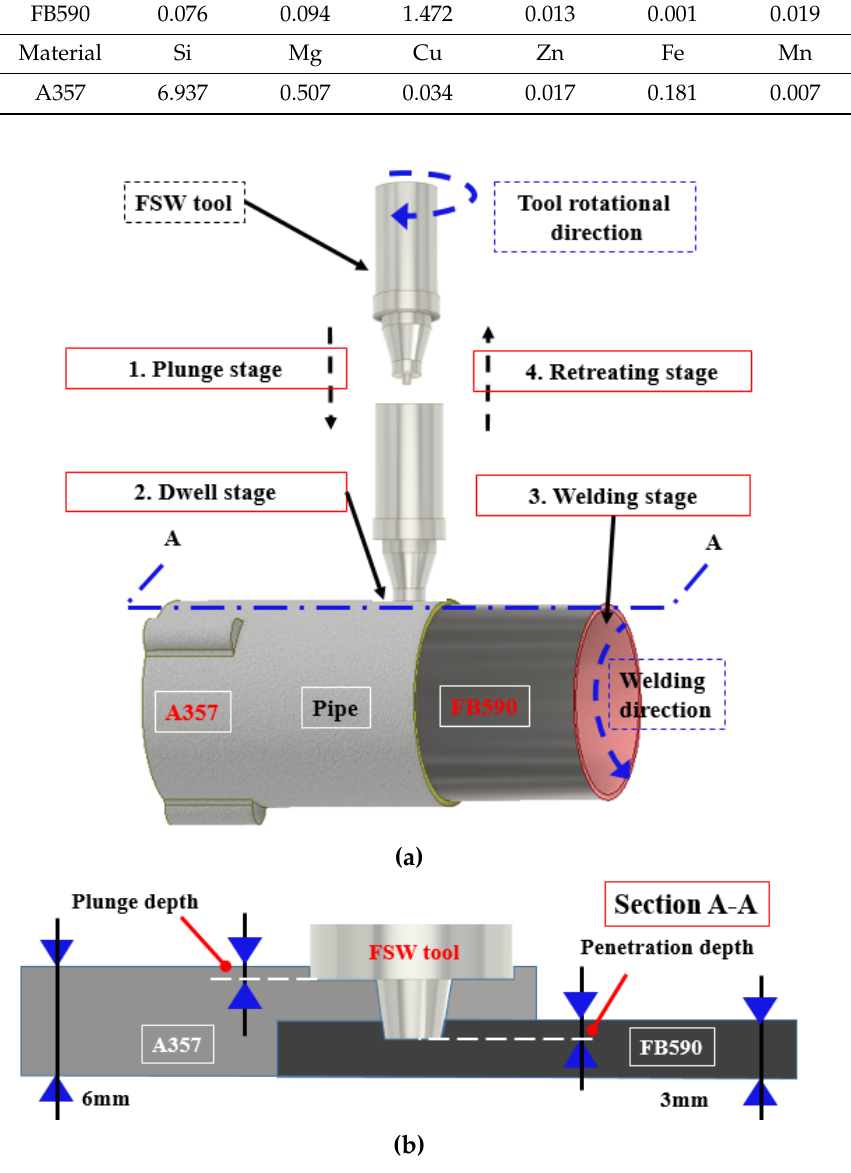
Figure 1. Schematic of FSW experimental configuration. ( a ) Four stages of FSW process; ( b ) plunge depth and penetration depth of FSLW.